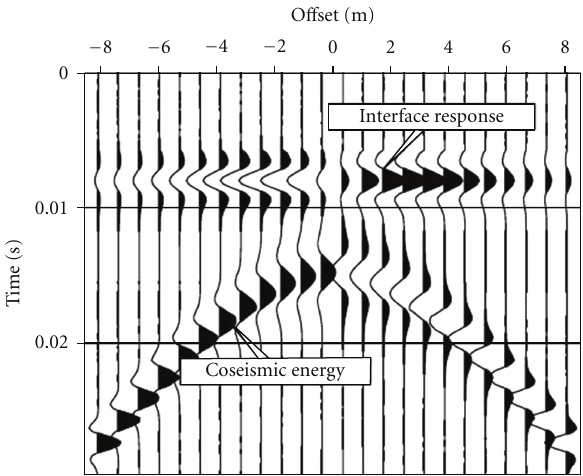
Figure 2: Model of the seismoelectric response to a hammer strike on the surface at position zero (from Haines [77]). The seismoelectric signal is shown as measured at the surface along a line centered on the seismic source. The interfacial signal is related to a contrast between properties of the media, such as the